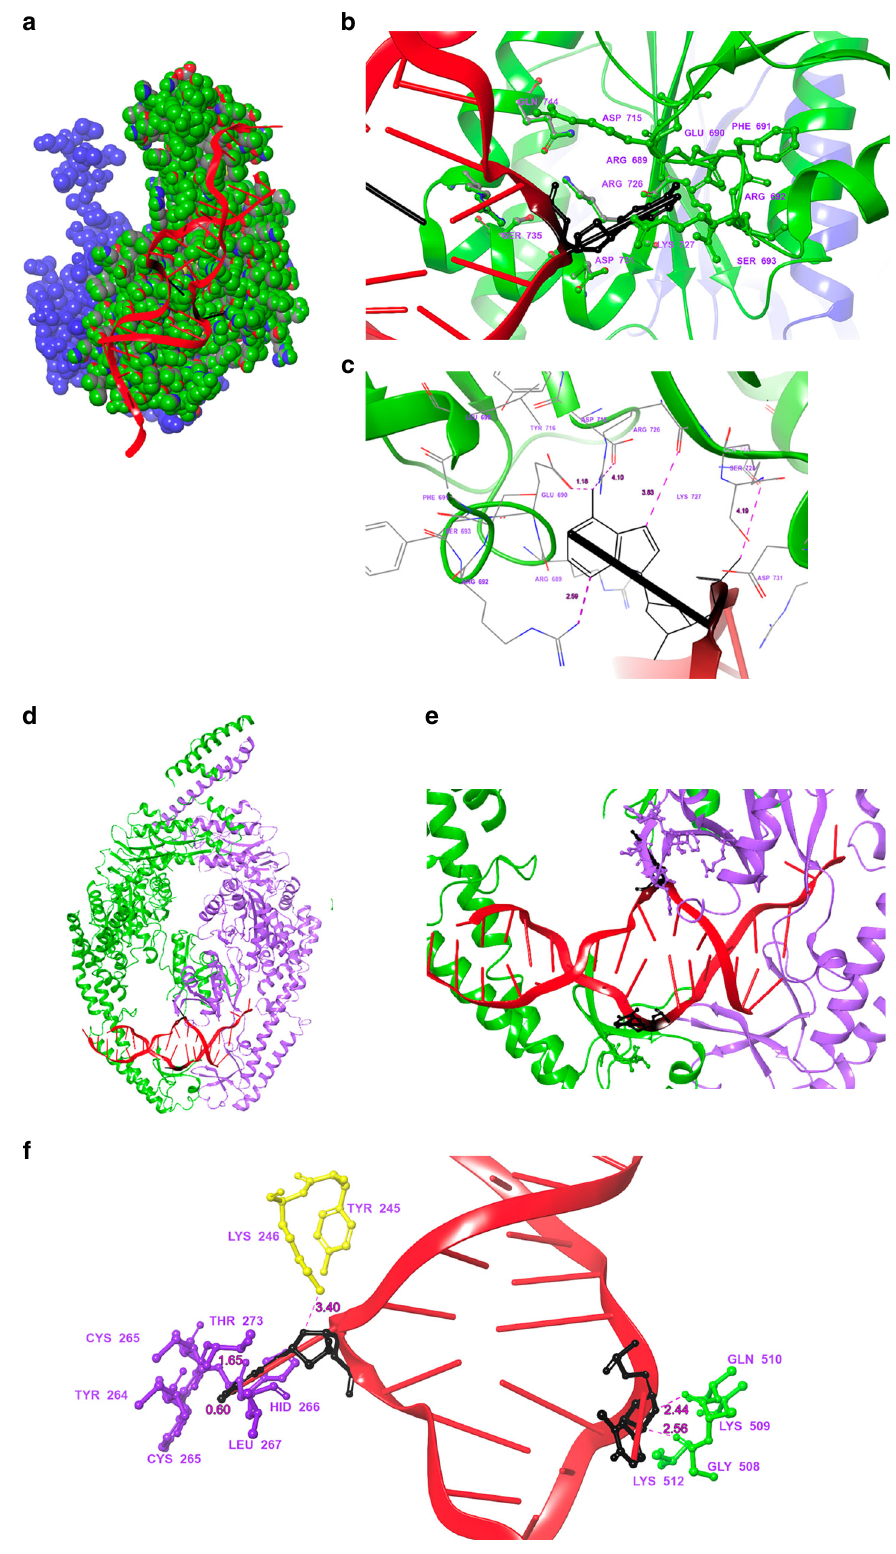
complex (Fig. 4a, b). Interface residues are highlighted to depict the number of signi fi cant residues that are potentially involved in binding/recognition of Z-DNA (Fig. 4b). We then measured the distances between the B-Z junction nucleotides to the interacting residues of the XPF endonuclease domain that were under 5 Å (Fig. 4c). This model predicts the most probable interaction